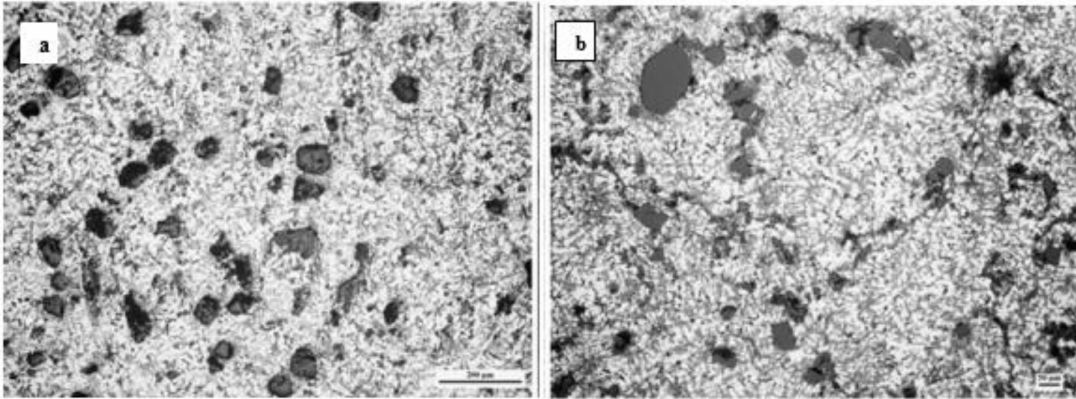
Figure 5. ( a ) Optical micrograph of DPS1 composites having 12% coarse and 3% fine particles showing eutectic Si morphology changes to globular from acicular in neighborhood to particles; ( b ) optical micrograph of DPS2 composites having 12% fine and 3% coarse particles displaying fine particles clustering